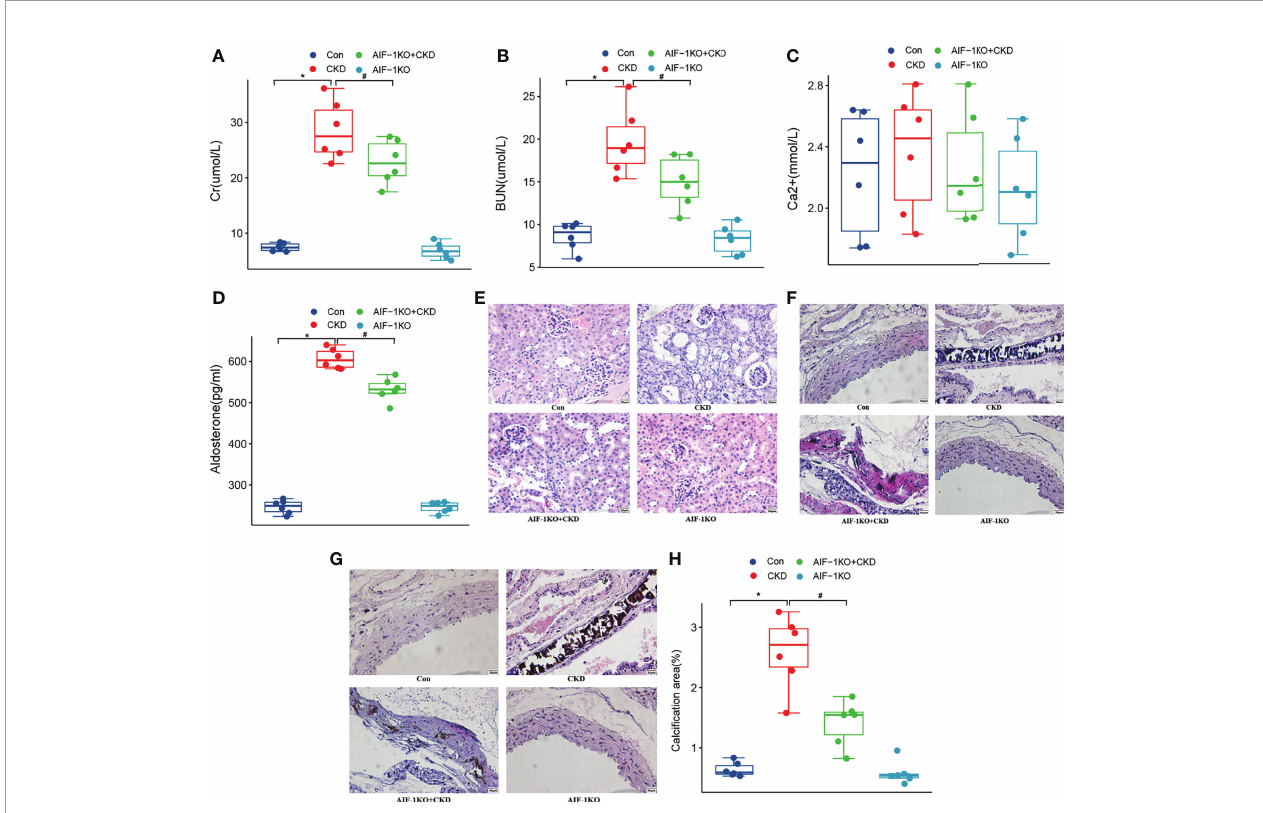
FIGURE 4 | The serum Cr, BUN, Ca 2+ , AIF-1, and Aldo levels in the AIF-1KO mice model (A – E) . The histomorphology of renal tissue(400X) (F) and thoracic aorta (400X) (G) . VonKossa staining(400X) (H) and quantitative analysis (I) . (n=6) (*P<0.05, Control group vs. CKD group; # P<0.05, CKD group vs. AIF-1KO+CKD